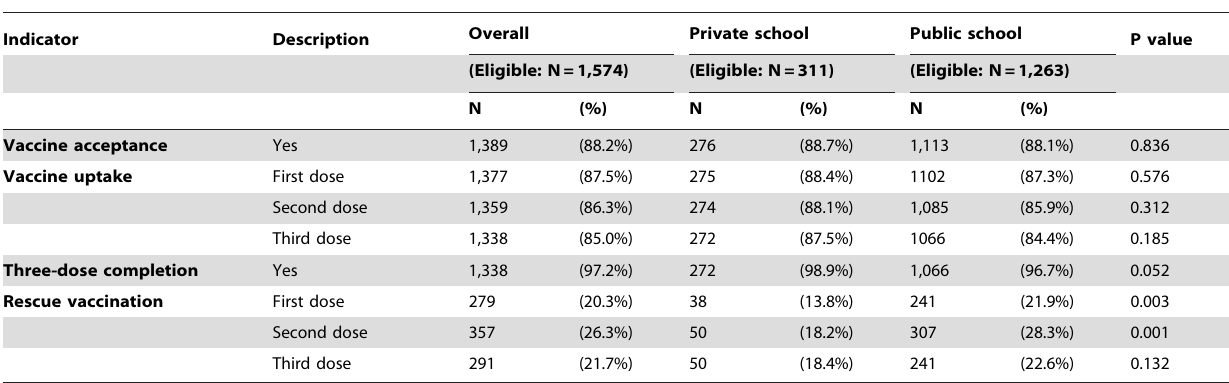
Table 2. Vaccination statistics according to school type.